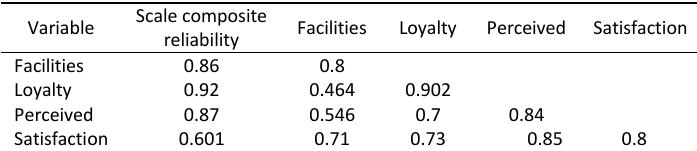
Table 2. The correlation matrix and Divergent validity Table 2: The correlation matrix and Divergent